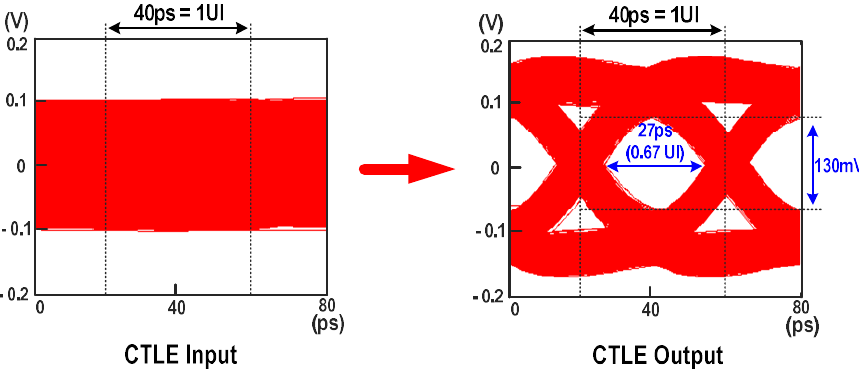
Figure 13. Post-layout simulation results of the proposed 25 Gb / s / lane CTLE operation with PRBS31 data sequence.